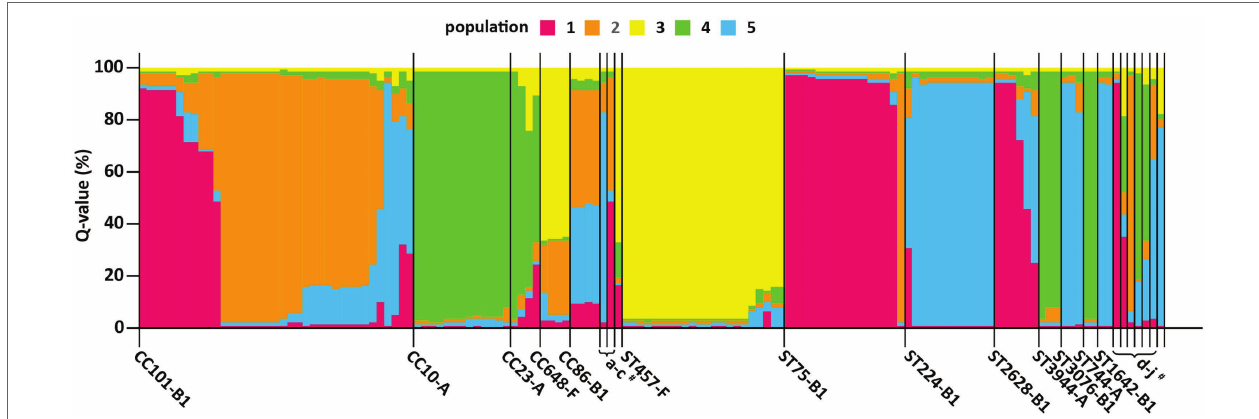
FIGURE 8 | A clonal population analysis of swine ESBL/AmpC-EC isolates using program structure. Each isolate was assigned to five populations based on their ExPEC VFs and E. coli phylogenetic group profile. The ExPEC VFs and E. coli phylogenetic group profile for each clonal population are presented in Table 2 . Each isolate is represented by a vertical segment and aligned horizontally according to CCs and STs (x-axis). The proportion of population (Q value) for each isolate is shown as 100% stacked bar plots, with proportions of colored sections representing the probability of belonging to each population within each segment (y-axis). CC, clonal complex; ST, sequence type; STNT, ST non-typable. # a, CC205-B1; b, CC376-B1; c, CC12-B2; d, ST3285-B1; e, ST953-A; f, NT-B1; g, ST7203-A; h, STNT-A; I, ST767-B1; and j,